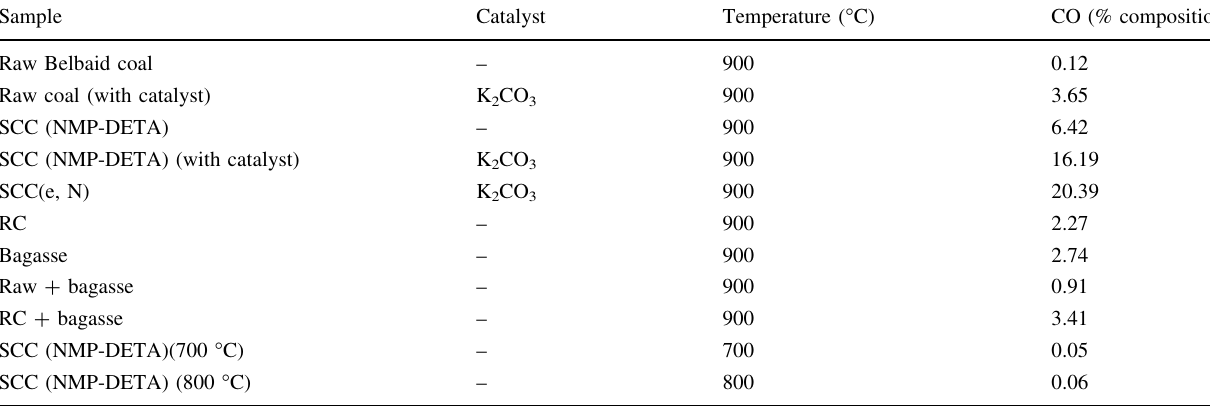
Table 3 Formation of CO (%) for the samples during CO 2 gasification of coals Sample